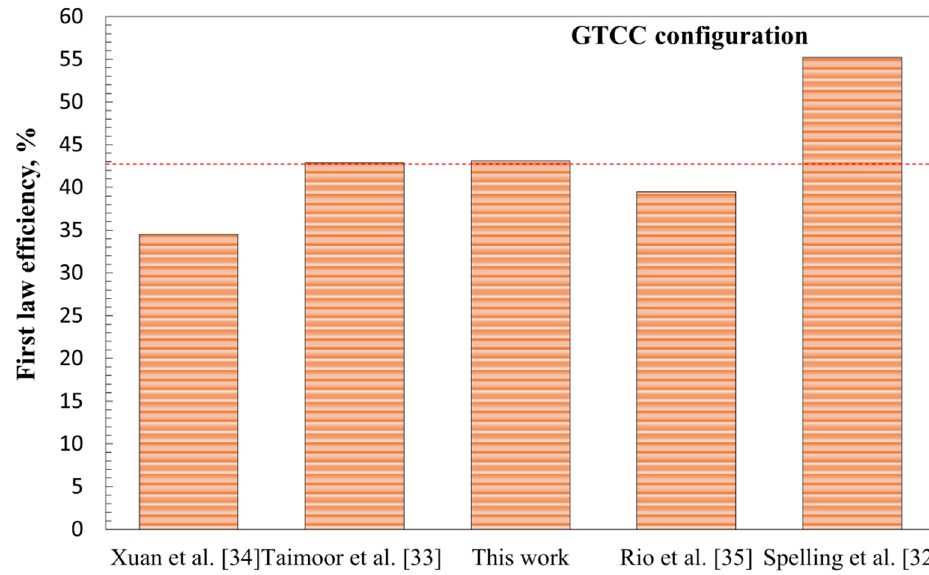
Figure 13. A rough comparison between FLE obtained for the proposed GTCC and the values reported for other power